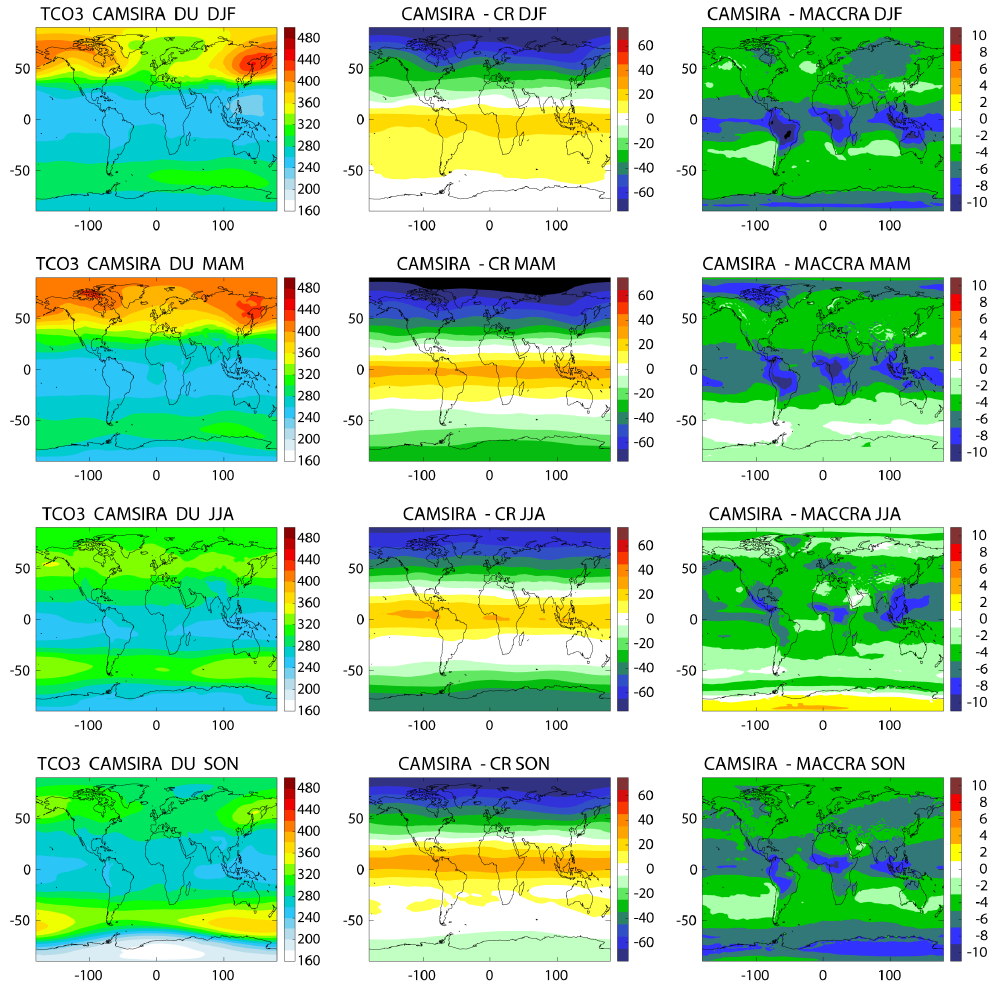
Figure 13. Seasonally averaged TC ozone (DU) from CAMSiRA (left), difference between CAMSIRA and the CR (middle), and difference between CAMSiRA and MACCRA (right, 2003–2012, different scale) for the seasons DJF (row 1), MAM (row 2), JJA (row 3), and SON (row